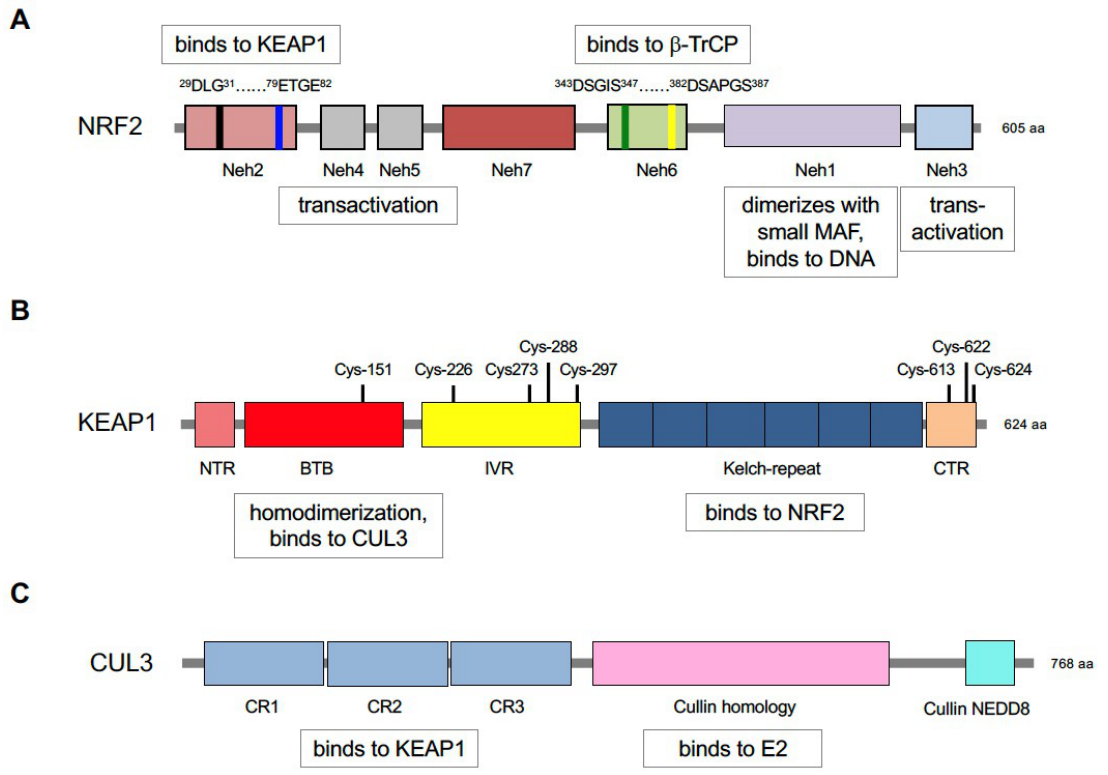
Figure 3. Domain structure of NRF2, KEAP1 and CUL3. The cartoon depicts: ( A ) the positions of the Neh1-Neh7 domains in human NRF2, along with amino acids associated with the DLG 31 and ETGE 82 motifs and their respective functions; ( B ) the positions of the NTR, BTB, IVR, Kelch-repeat and CTR domains in KEAP1; ( C ) the positions of the cullin repeat 1 (CR1), CR2, CR3 and cullin homology (CH) domains in CUL3.